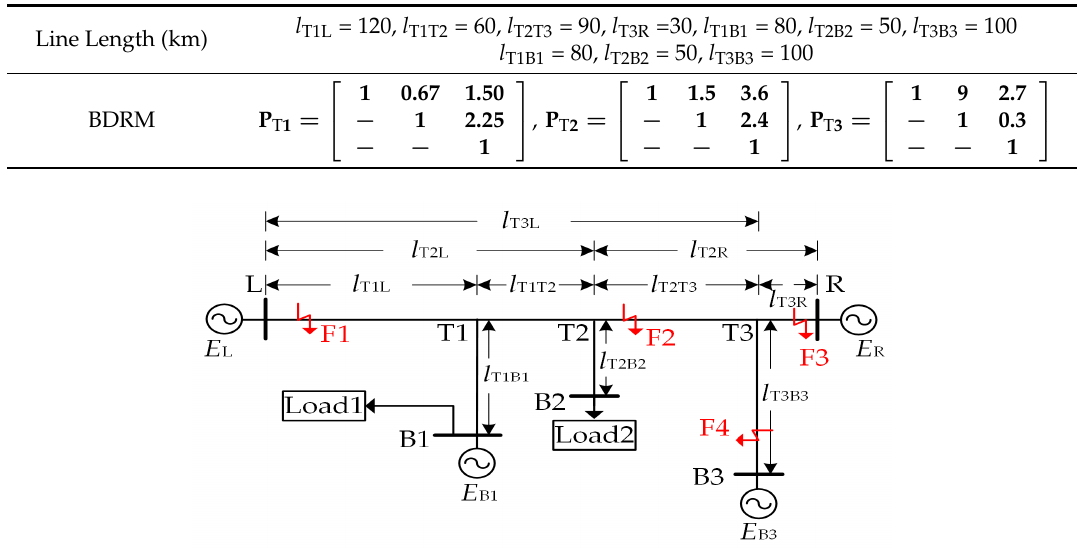
Table 3. Branch distance ratio matrixes (BDRMs) in simulated lines.